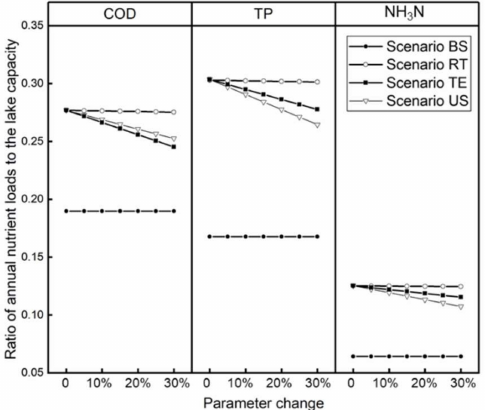
Figure 14. Impact of parameter change on the lake capacity under four load reduction scenarios using 2016 as the base year. Circles on each curve indicate the ratio of annual river loads to the lake capacity with the corresponding parameter